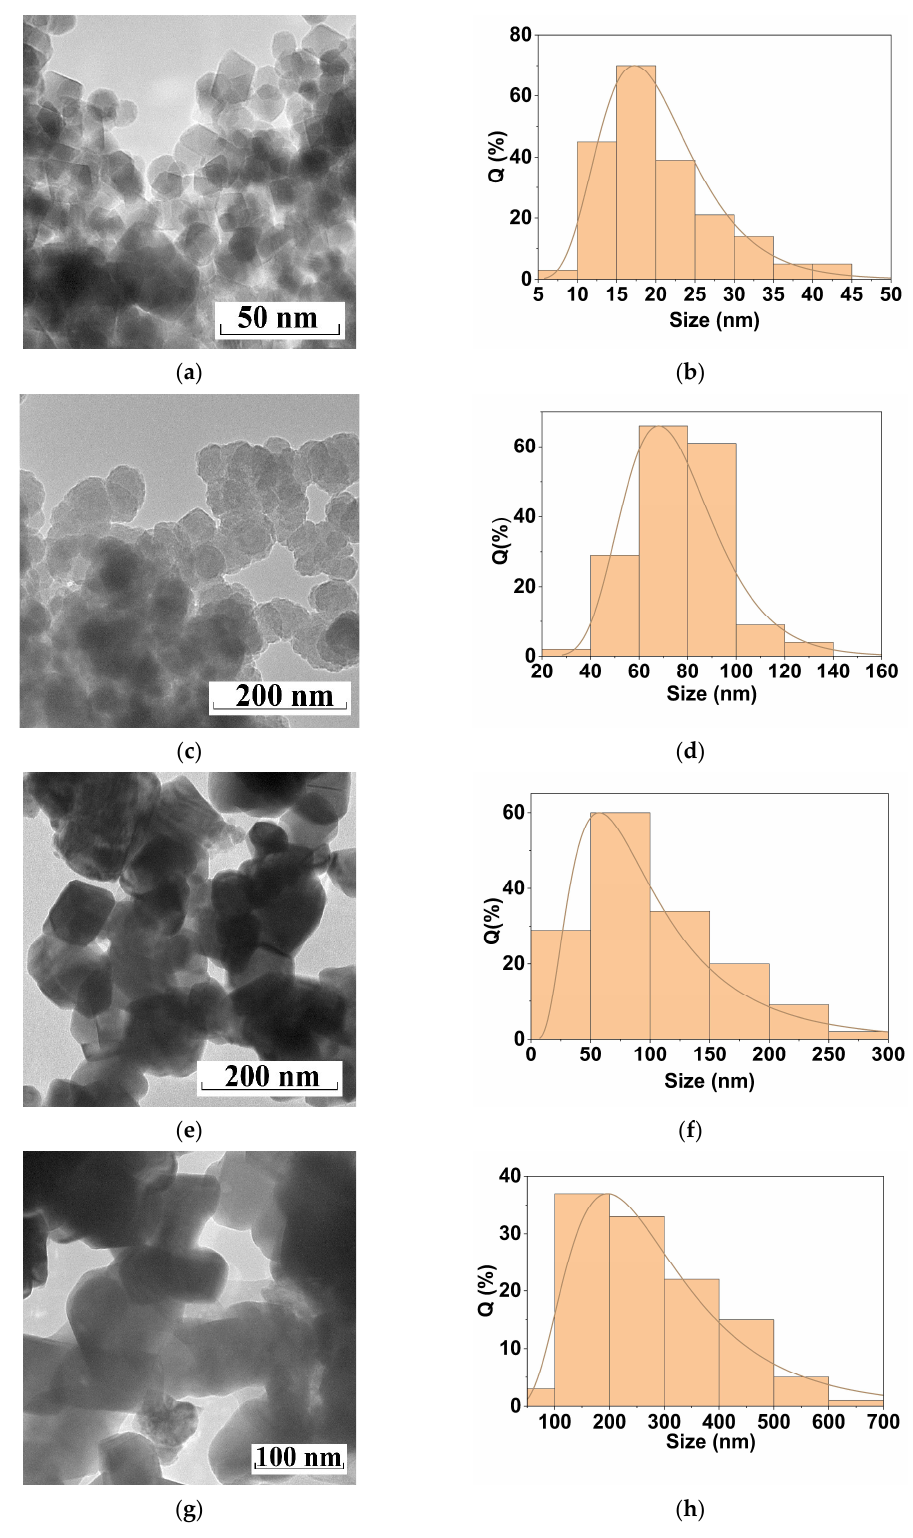
Figure 5. TEM images ( left panel) and the particle size distribution diagrams ( right panel) for the samples of CuFe 2 O 4 calcined at 800 °C: ( a , b ) obtained with dextran-40; ( c , d ) obtained with inulin; ( e , f ) obtained with dextran-70; and ( g , h ) obtained without polysaccharides.